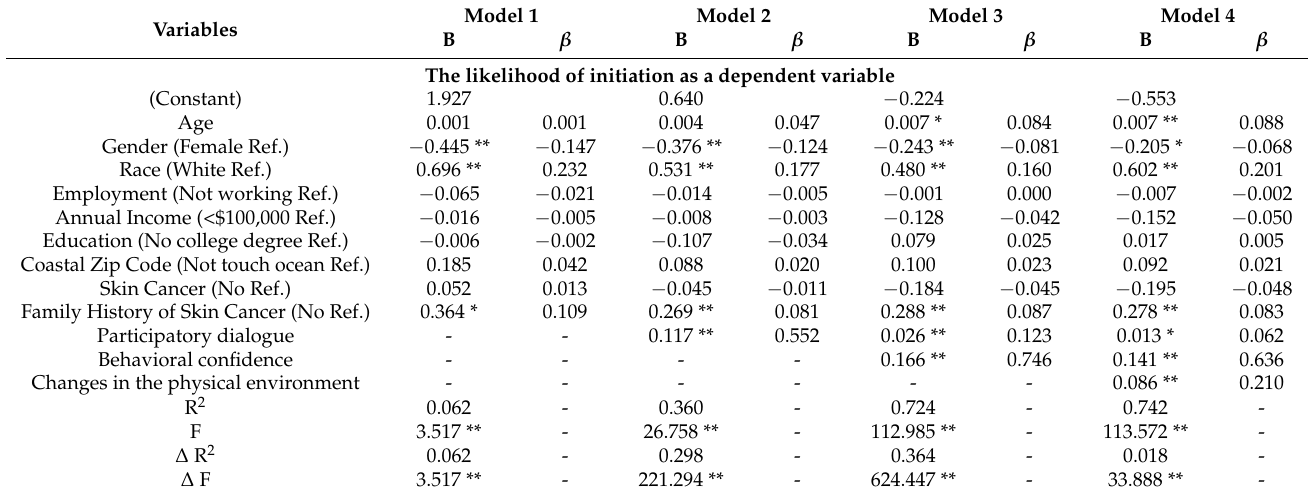
Table 3. Hierarchical multiple regression (HRM) predicting likelihood of initiation and sustenance among respondents who used sunscreen ( n =